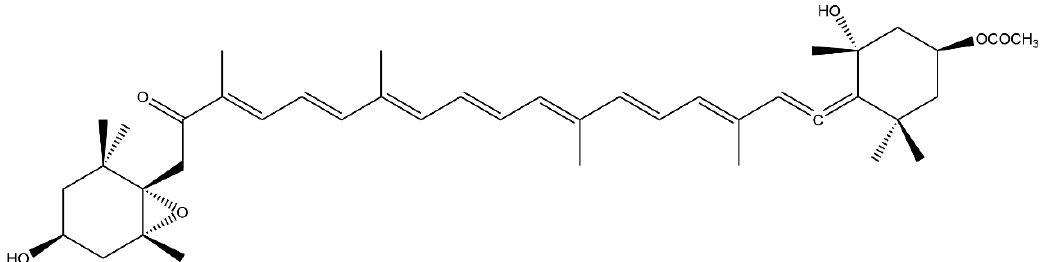
Figure 1. Chemical structure of fucoxanthin.